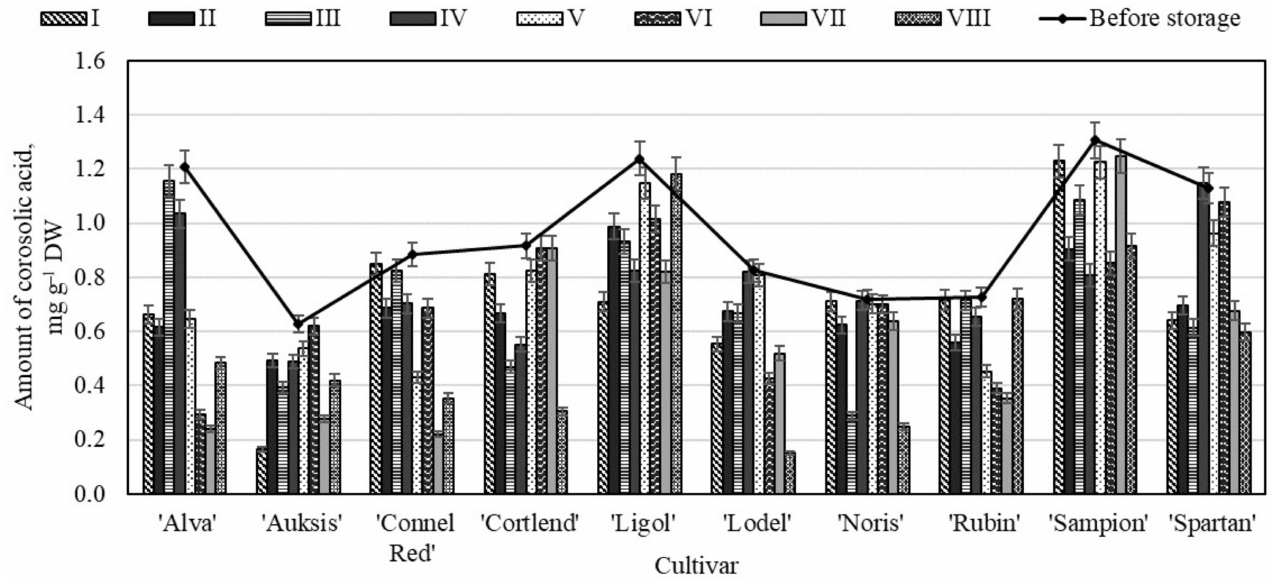
Figure 9. Changes in the amount of corosolic acid in the apple peel samples before and after storage in